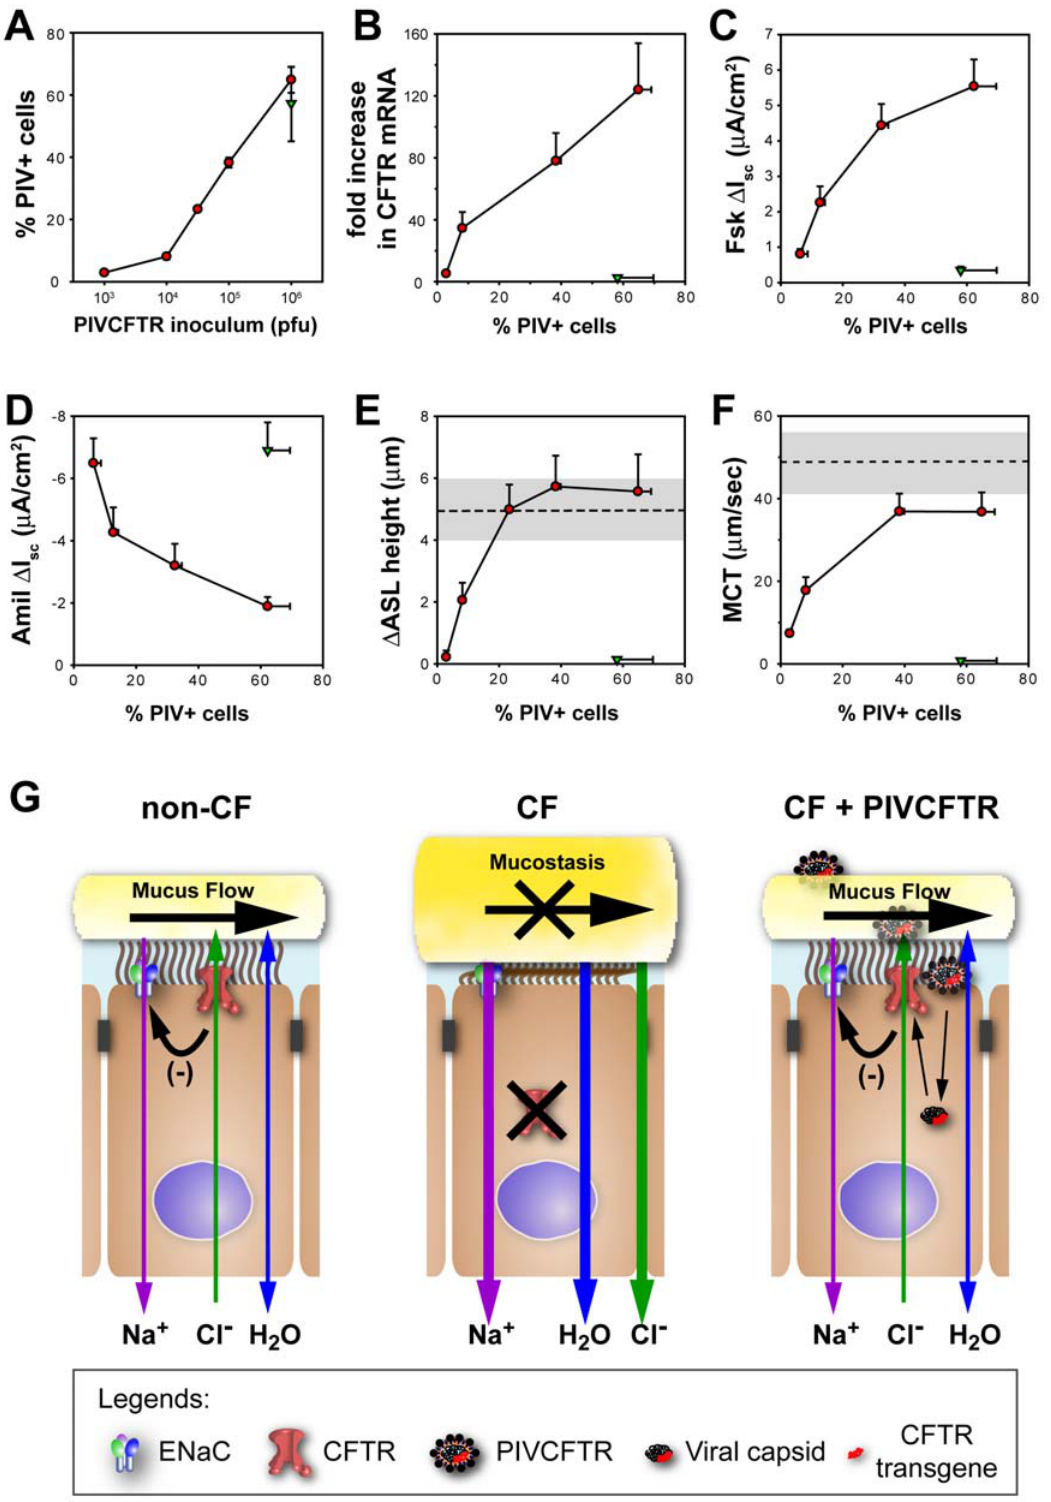
Figure 7. How many CF airway epithelial cells require CFTR to restore ASL homeostasis and MCT to non-CF HAE levels? (A) Quantitation of the percentage of PIV F-positive cells 24 h after inoculation with different concentrations of PIVCFTR (10 3 –10 6 PFU) and correlation of percentage of PIVCFTR-positive cells to: (B) increased CFTR mRNA expression levels; (C) Fsk-activated changes in I sc ; (D) amil-induced changes in I sc ; (E) ASL height; and (F) MCT rates. All measurements were made 24 h after inoculation with PIVCFTR (closed red circles) or controls (PIVGFP or PIV D F508CFTR, closed green triangles) as described in Materials and Methods. n . 11 for each data point representing cultures from 2 or 3 different donors. Dashed lines and grey shaded regions represent mean and standard deviations of ASL heights and MCT rates measured in parallel experiments with non-CF HAE. For these experiments, approximately 80% of surface cells were ciliated cells. (G) Schematic representation depicting